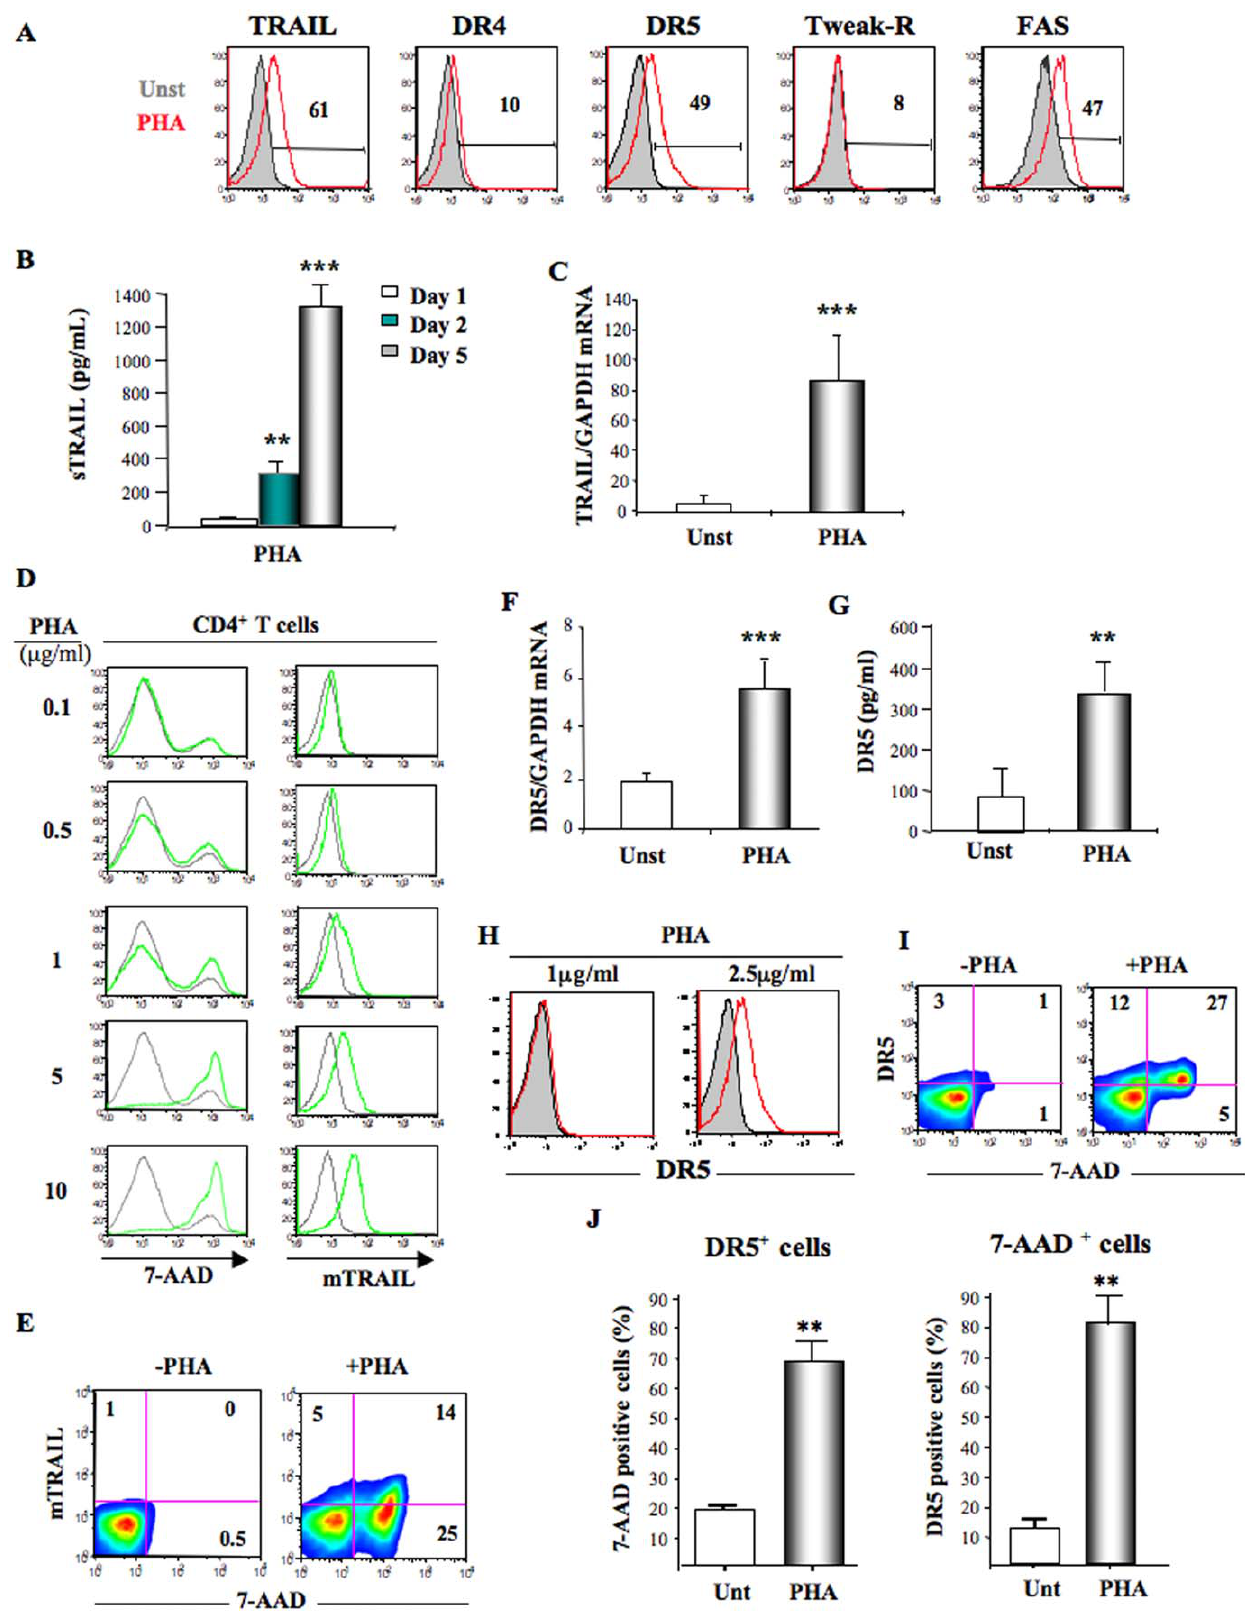
Figure 2. TNF family member expression by PHA-activated CD4 + T cells. A. CD4 + T cells from healthy donors were cultured 24 h in presence (red histograms) or absence (solid grey histograms) of PHA (2.5 m g/ml) and were phenotyped for TRAIL, DR4, DR5, Tweak-R and Fas expressions by FACS. B. Quantification of soluble TRAIL production by ELISA of PHA-activated CD4 + T cells after 1, 2 and 5 days of culture. C. TRAIL mRNA PLoS ONE |